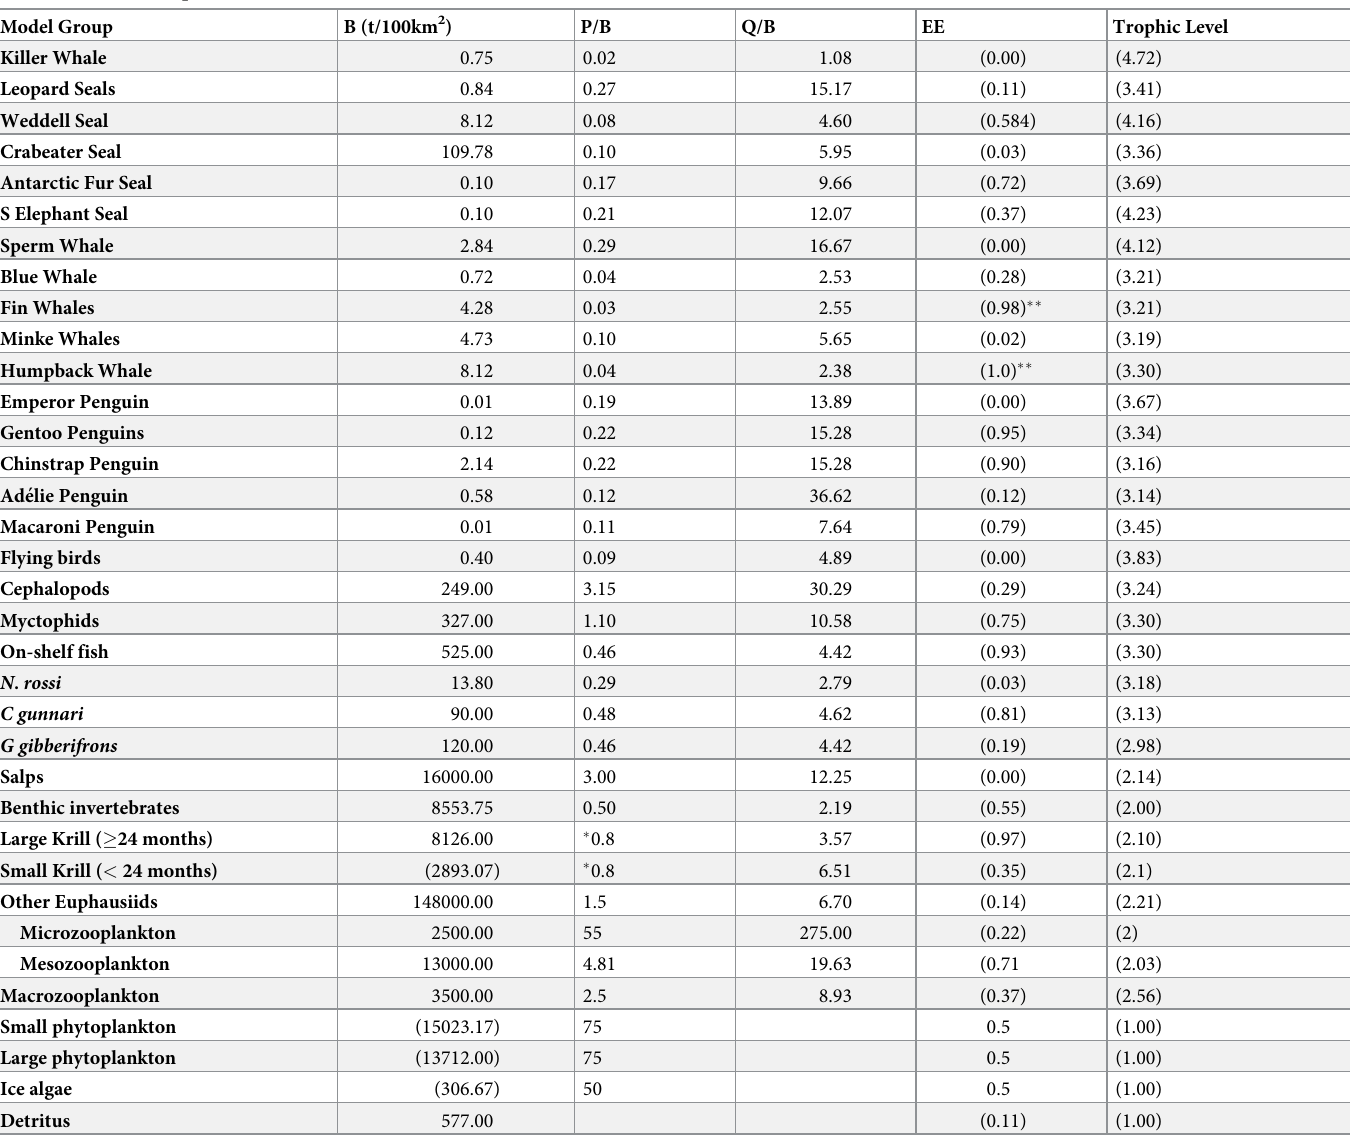
Table 2. Balanced ecopath